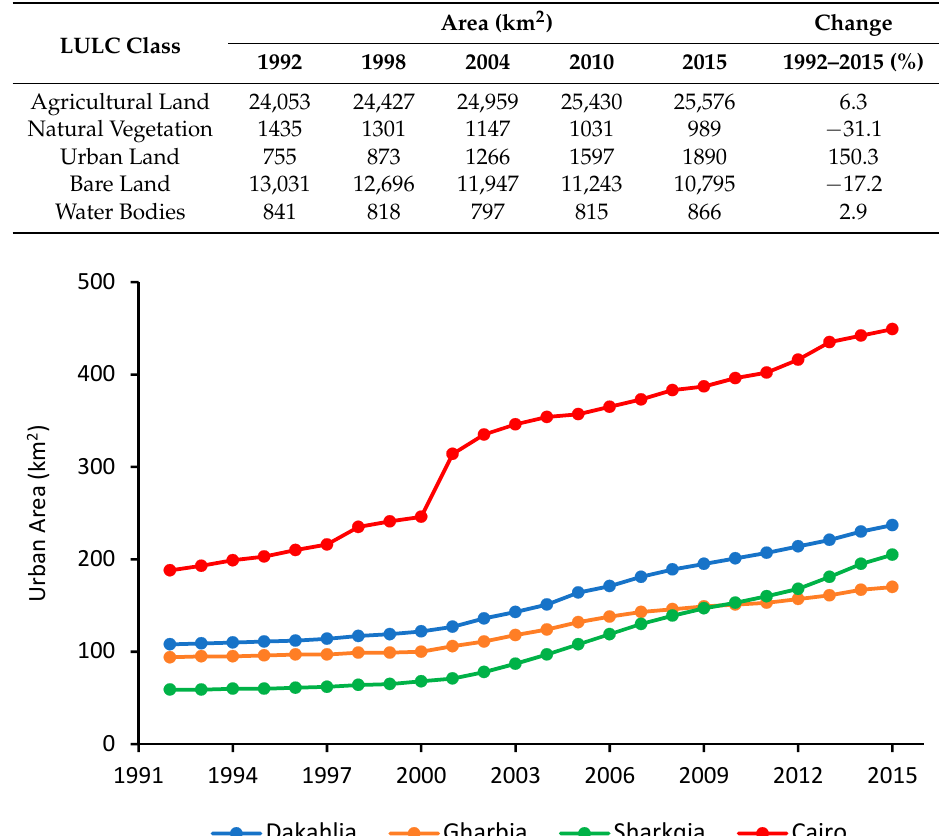
Figure 5. Urbanization in Dakahlia, Gharbia, Sharkqia and Cairo over the study period.